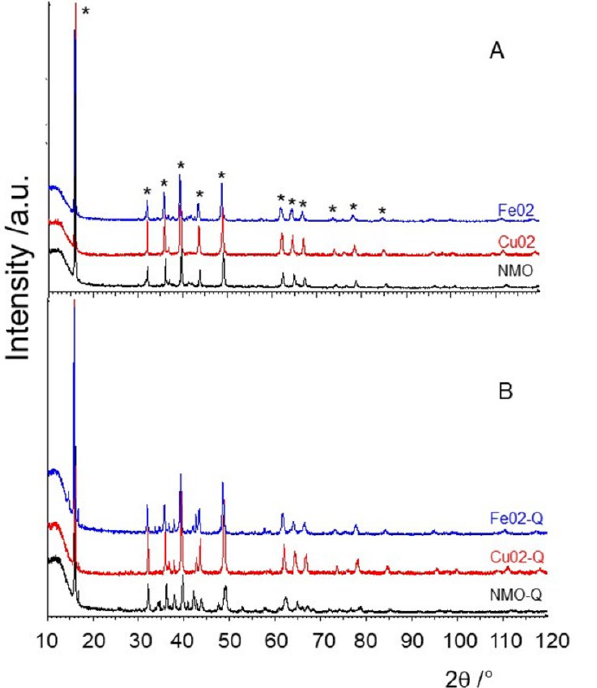
Figure 1. XRPD patterns of the samples obtained from the slow cooling ( A ) and quenching ( B ) processes. The stars mark the main reflections of P2 polymorph (valid for both ( A , B ) panels).